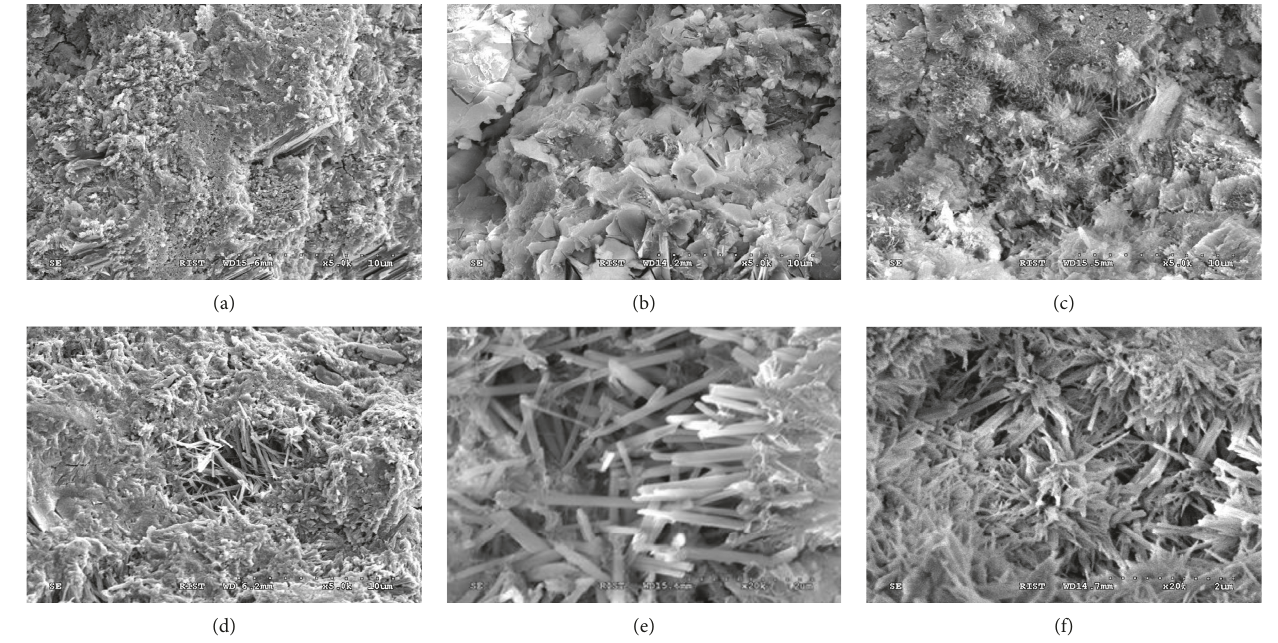
Figure 9: SEM images of hydrates. (a) O100 ( × 5k). (b) B30-S20 ( × 5k). (c) B30-S10-G10 ( × 5k). (d) B30-G20 ( × 5k). (e) B30-S10-G10 ( × 20k). (f) B30-G20 ( ×